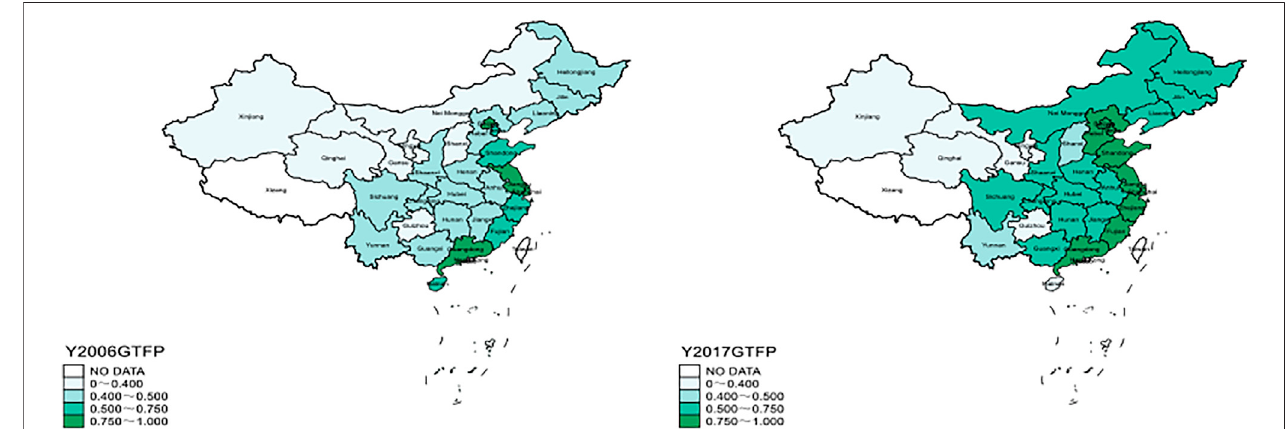
FIGURE 1 | China ’ s GTFP in 2006 and